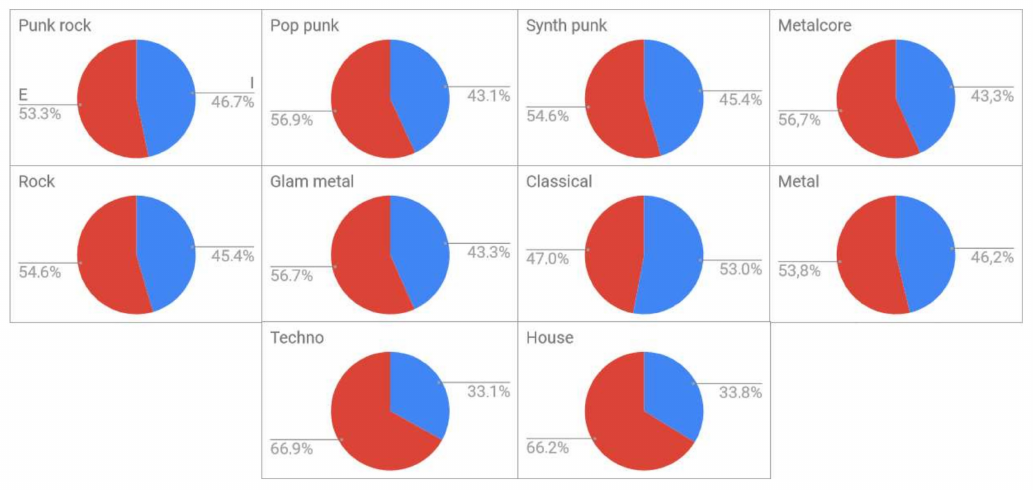
Figure 2. Percentage of votes on a music genre which were given by introverts and extraverts.